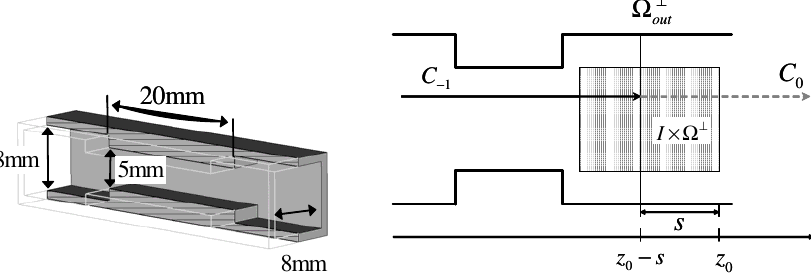
for direct integration and cross section (cid:1) ? 1